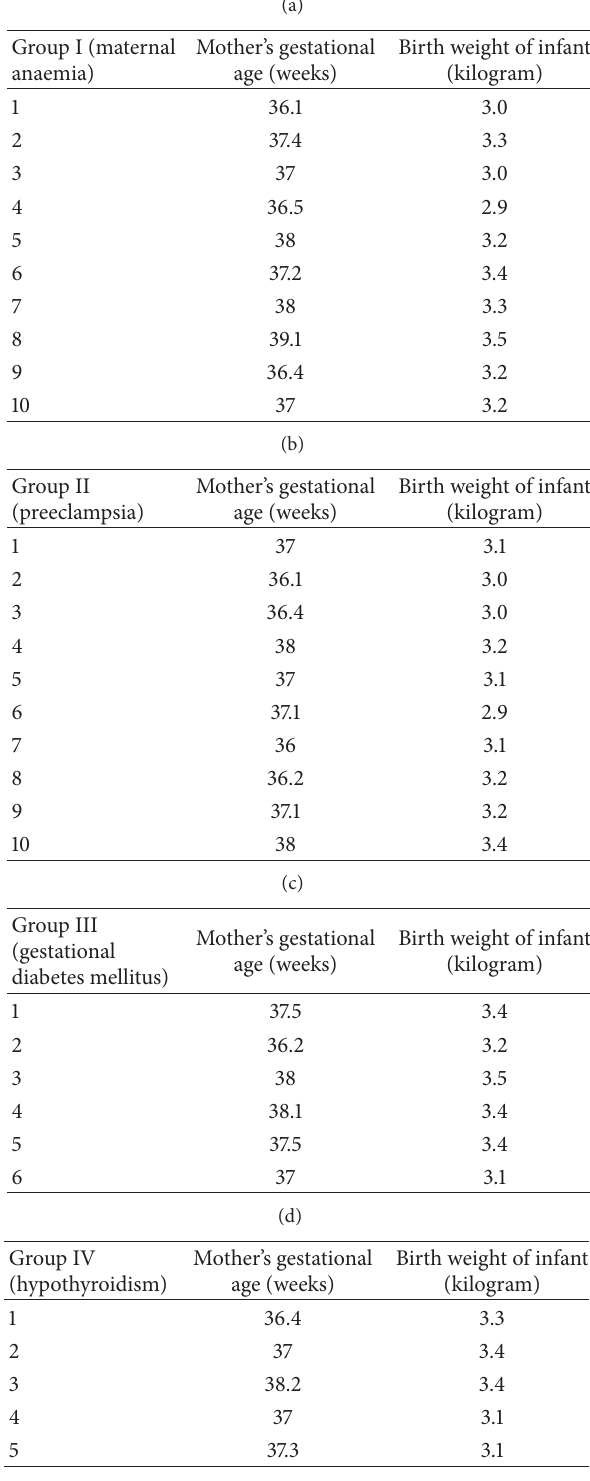
Table 1: Gestational age and birth weight in control group. Mother’s gestational Control group (case) age (weeks)